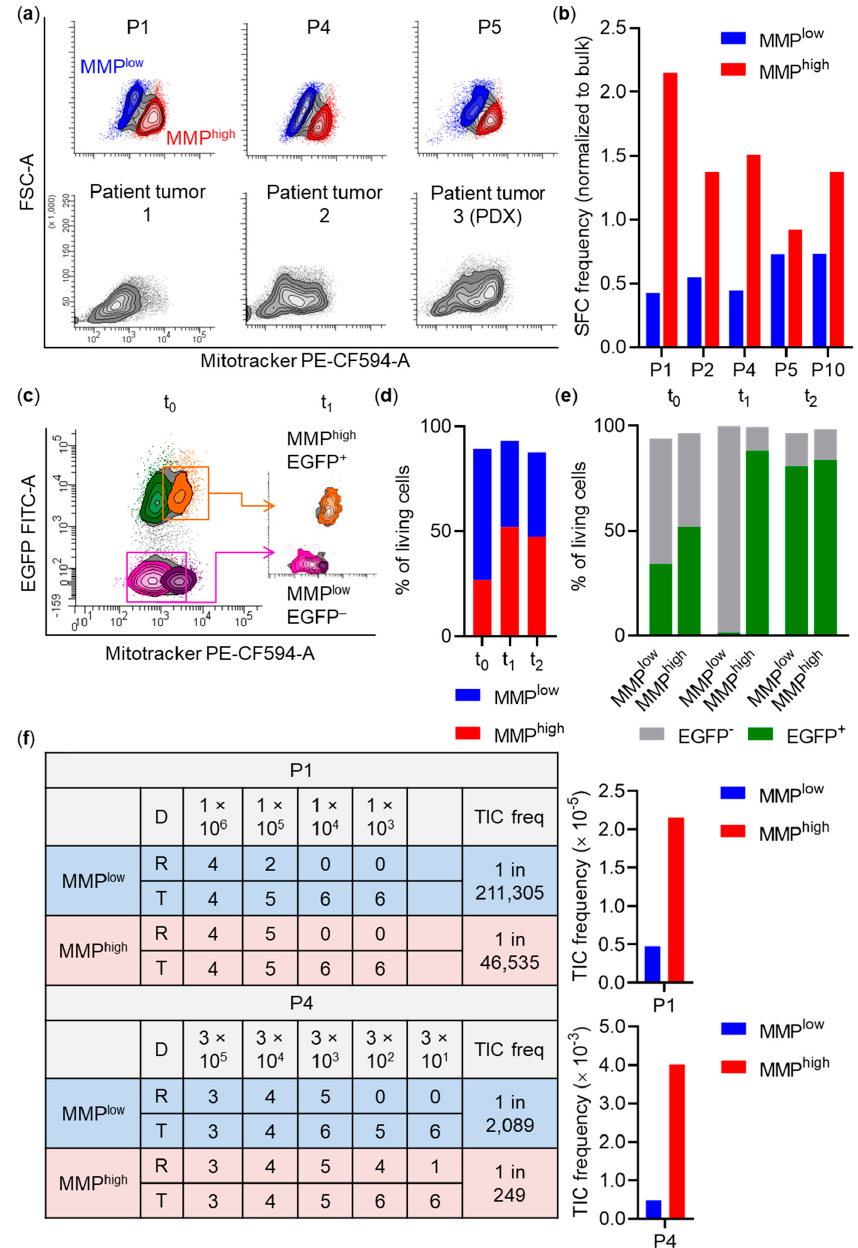
Figure 5. Association of tumor-initiating cell (TIC) activity and mitochondrial membrane potential (MMP). ( a ) Top: Heterogeneous MMP staining (Mitotracker) of spheroid cells assessed by flow cytometry (representative plots shown). Colored cell populations indicate sorted fractions. Bottom: Heterogeneous MMP staining pattern in tumor cells. Axis scale numbers are representative for all plots. PDX, patient-derived xenograft. ( b ) Spheroid-forming cell (SFC) frequencies of MMP sorted spheroid cells (P1, P4: n = 3; P5: n = 2; P2, P10: n = 1) determined by in vitro limiting dilutions. SFC frequencies were calculated based on sphere formation 5–7 days after seeding and normalized to bulk (P1, P4, P5: n = 2; P2, P10: n = 1). ( c ) Experimental layout of co-cultivation experiments. x- and y-axis are displayed biexponentially. Results for a representative spheroid culture (P1) are shown. Axis scale numbers are representative for all plots. EGFP, enhanced green fluorescent protein. ( d , e ) Composition of ( d ) MMP low and MMP high cells or ( e ) EGFP – and EGFP + cells in the MMP low and MMP high subpopulations over time. t 0 : before, t 1 : directly after, t 2 : 21 days after sort. ( f ) Results of limiting dilutions in vivo. Left: Overview of dose (D) and response (R). Right: TIC frequencies of MMP sorted spheroid cells. TIC frequencies were calculated based on tumor formation seven weeks (P1: n = 42 mice) or five weeks (P4: n = 48 mice) after transplantation. Freq, frequency; T,